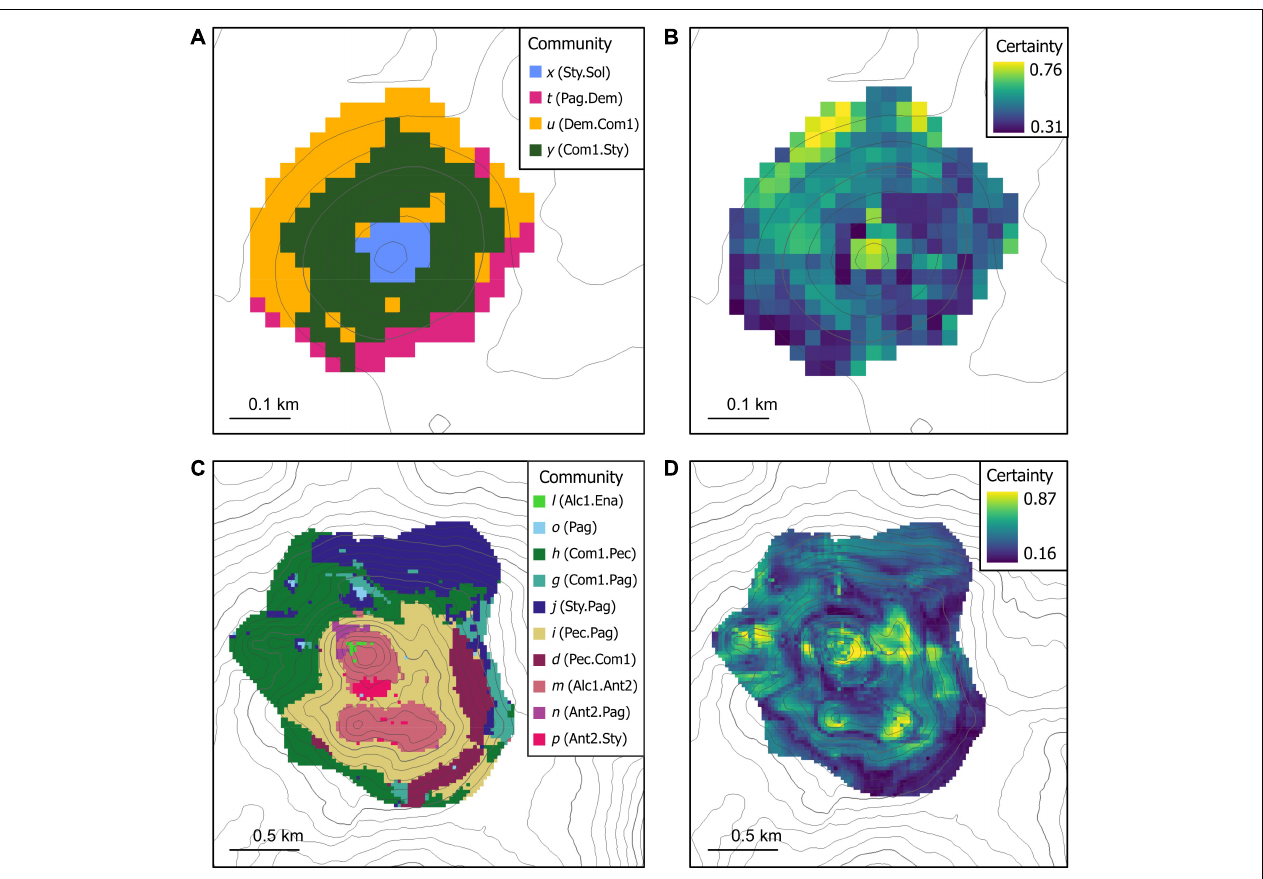
FIGURE 6 | Random forest model predictions of community distributions (left-hand panels) and model certainty calculated from bootstrapped model iterations, visualized as mean proportion of votes where a higher proportion of votes indicates higher model certainty (right-hand panels) for panels (A,B) Ghoul and (C,D) Diamond Head. Contour lines represent 20 m depth intervals. For community codes and types, see Figure 3 and Table 2